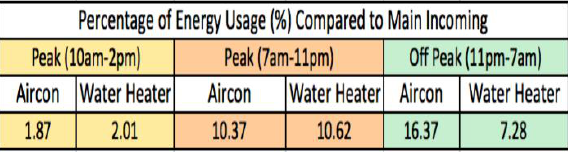
Figure 2. Survey summary results of 500 households.